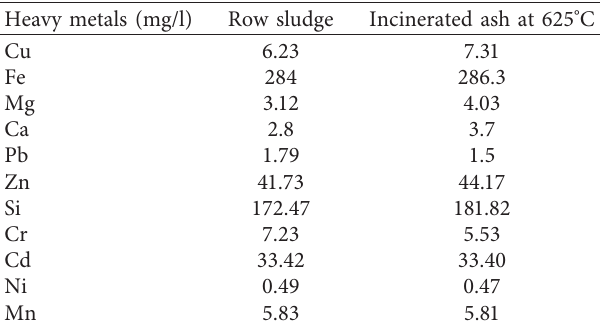
Table 3: Proximate test result.